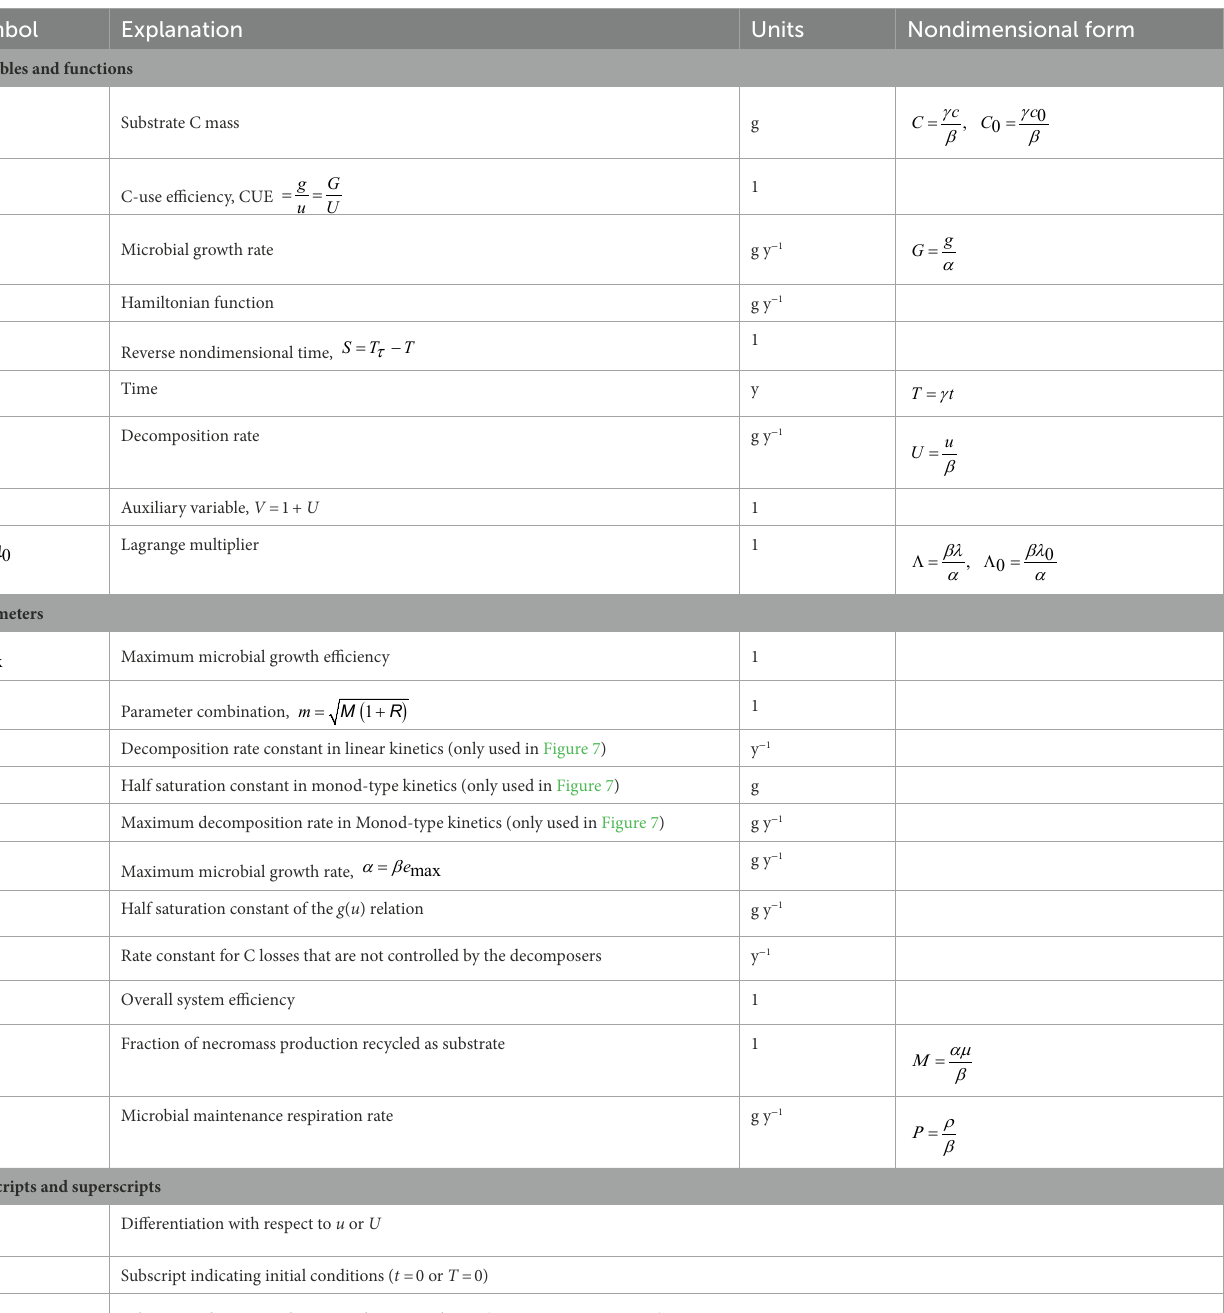
TABLE 1 Symbols and